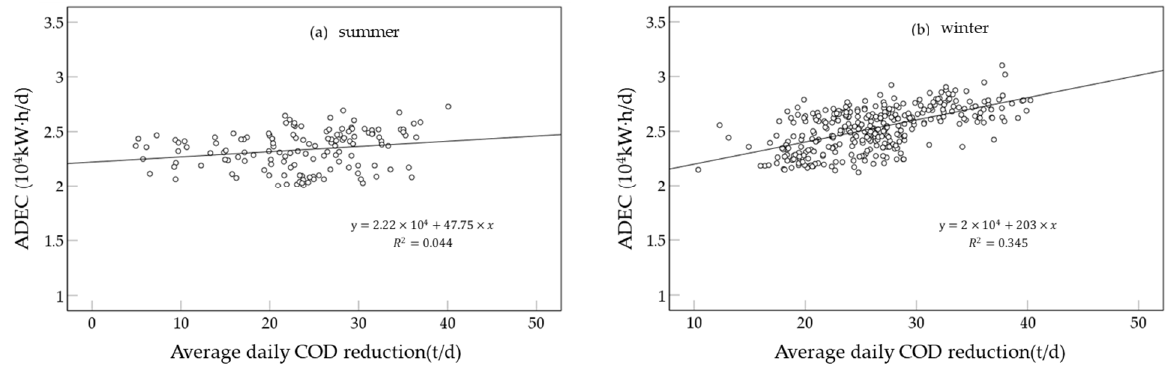
Figure 13. The variation of electricity consumption with the daily COD reduction in ( a ) summer and ( b ) winter.